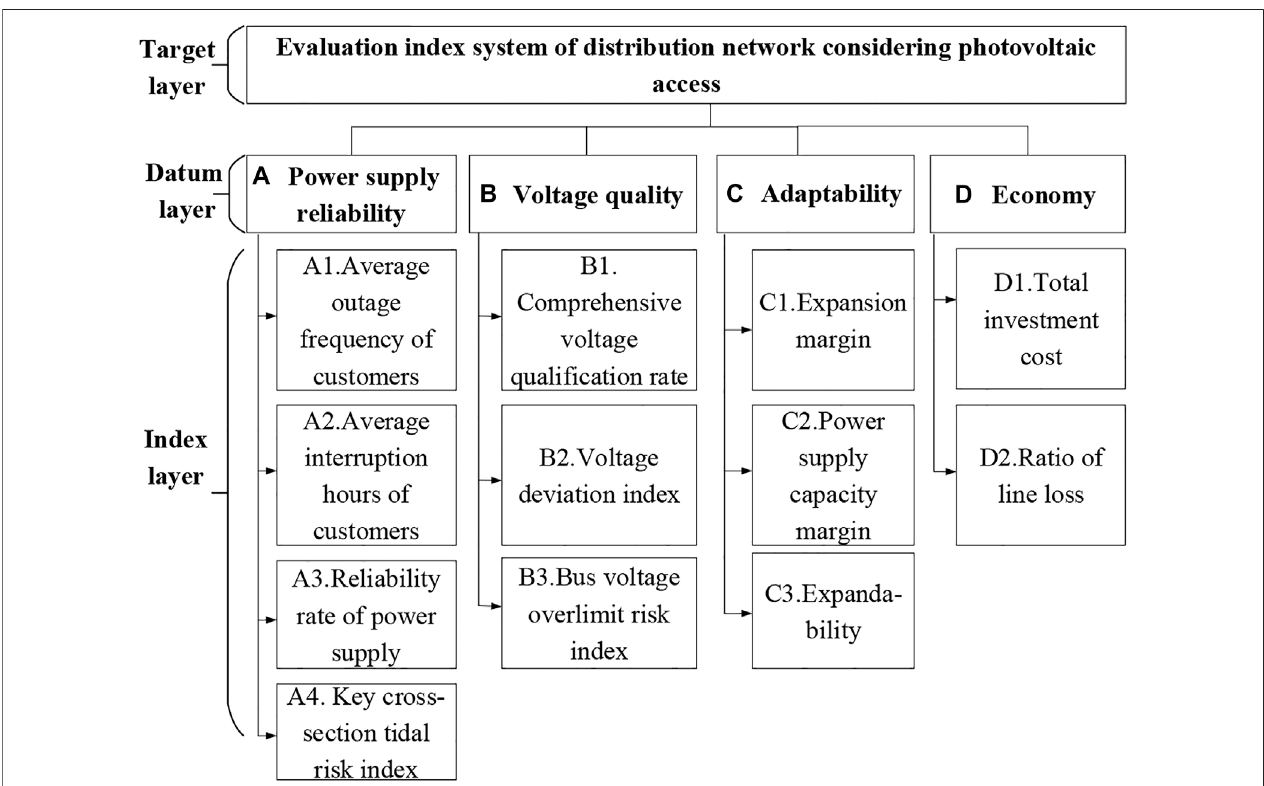
FIGURE 1 | Index evaluation system of distributed photovoltaic power generation access to the distribution